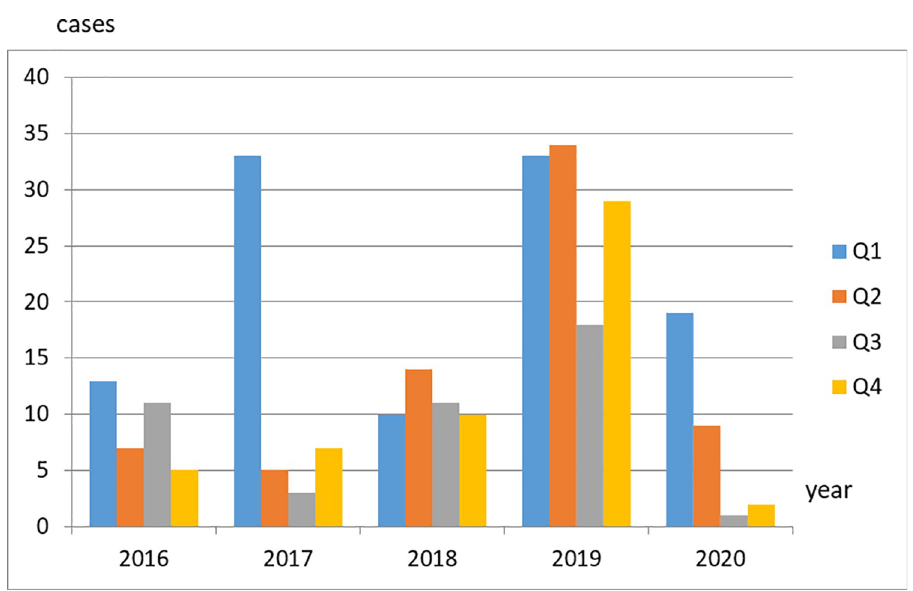
Fig 1. Proportion of pertussis cases in Indonesia between 2016 and 2020 based on period/quarterly (Q)